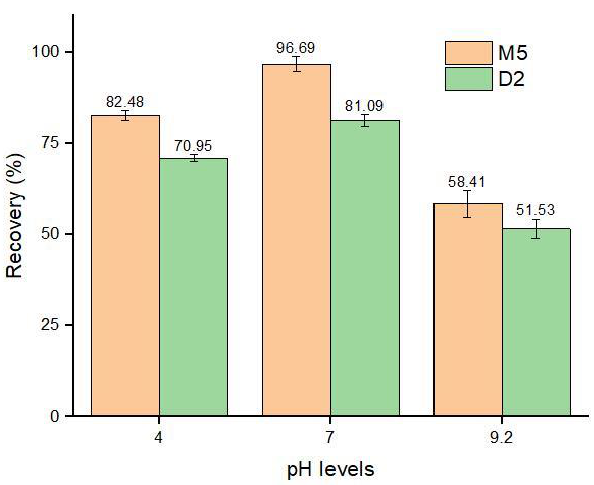
Figure 11. Adsorption recoveries (%) by MIPs in different pH mediums.